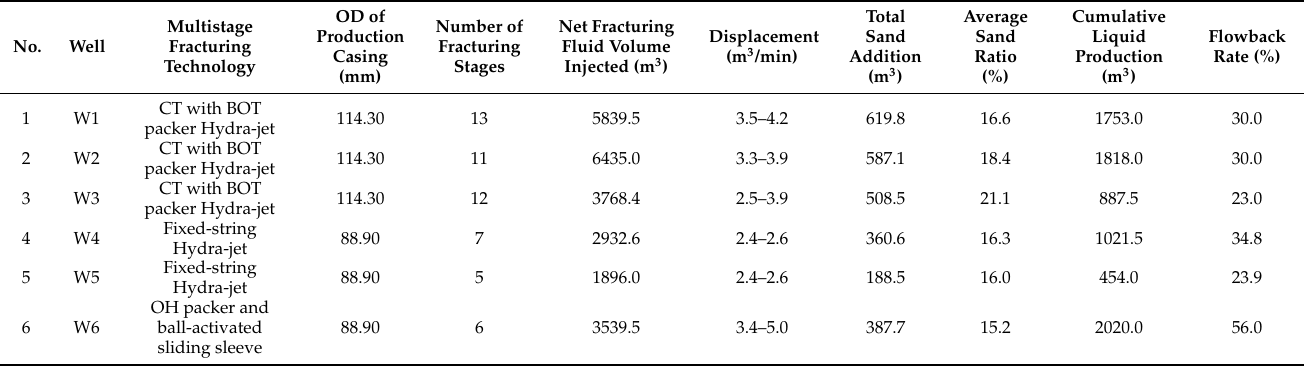
Figure 7. Effective thickness contour and well location map of the enrichment area, S2 formation, Block M. Table 3. Parameters of multistage fractured horizontal